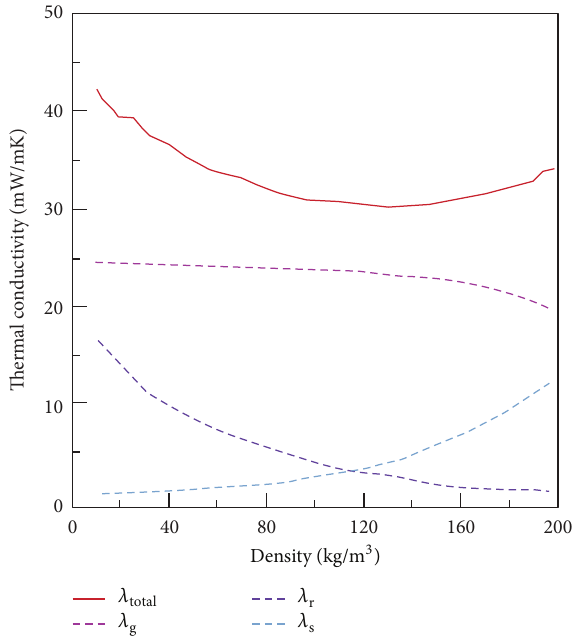
Figure 7: Relationship between the porosity and thermal conduc- tivity of solids for VIP core